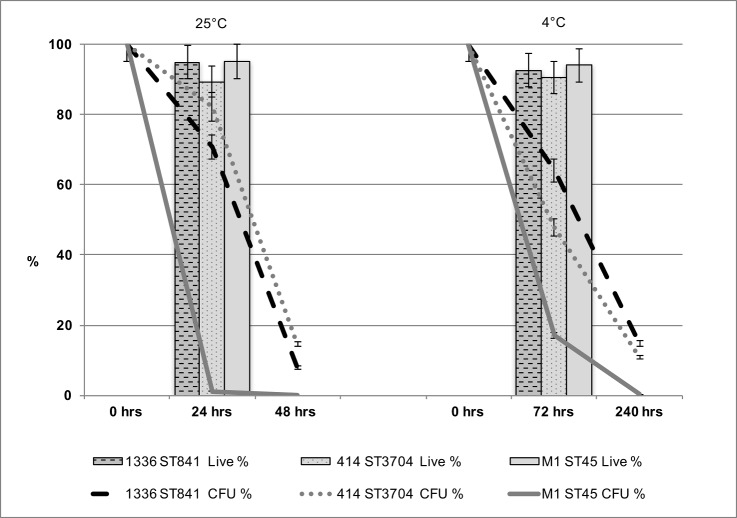
Culturability of C. jejuni strains during survival periods in sterile distilled water.The percentage of the original inoculum retaining culturability is shown at 0 h, 72 h and 240 h at 4°C and at 0 h, 24 h and 48 h at 25°C. The percentage of viable cells at 72 h at 4°C and 24 h at 25°C (indicated by the line graphs) was determined by LIVE/DEAD staining (BacLight, Invitrogen) for C. jejuni. The error bars represent a 5% error, three independent biological replicates were performed.